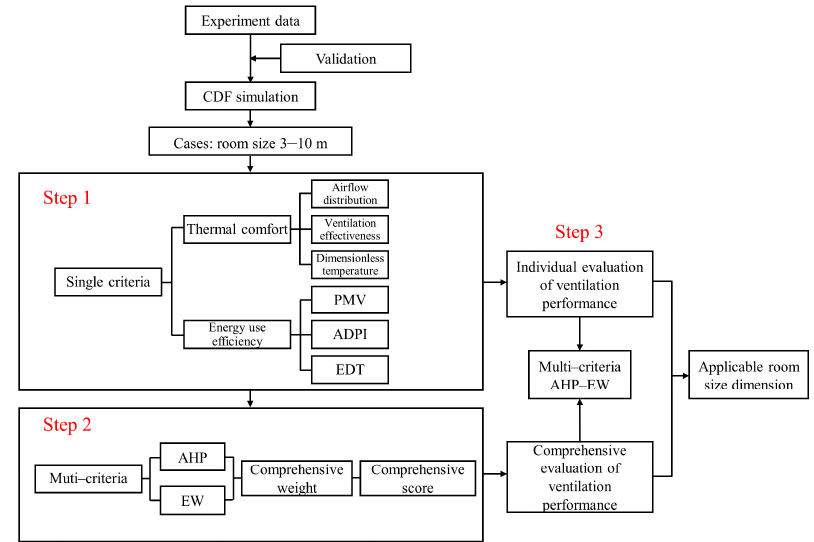
Figure 1. Study flow